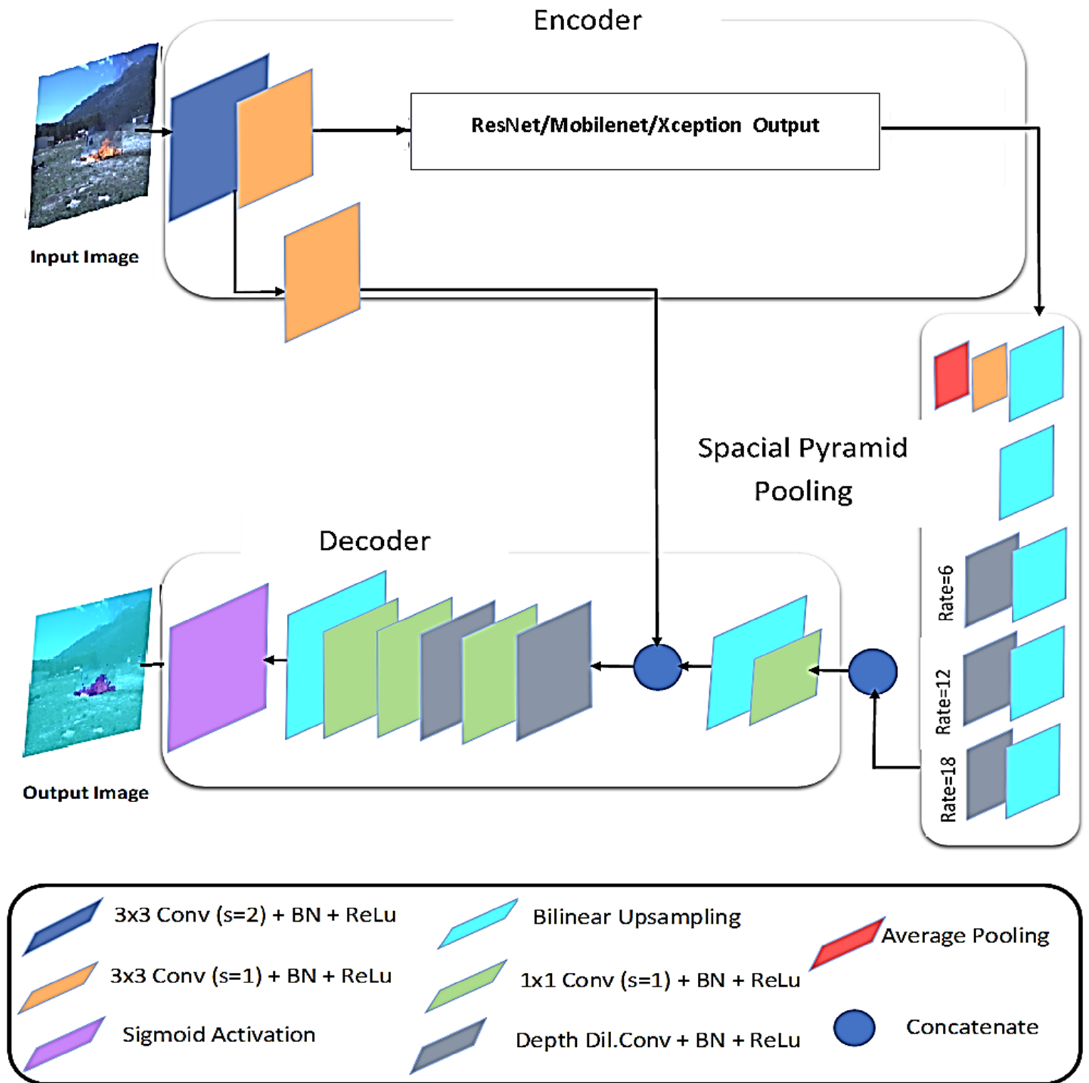
Figure 3. The segmentation module architecture: The encoder block is for feature extraction, deploying atrous convolutions with different rates (spatial pyramid pooling block). The decoder block helps reduce the obtained feature map.